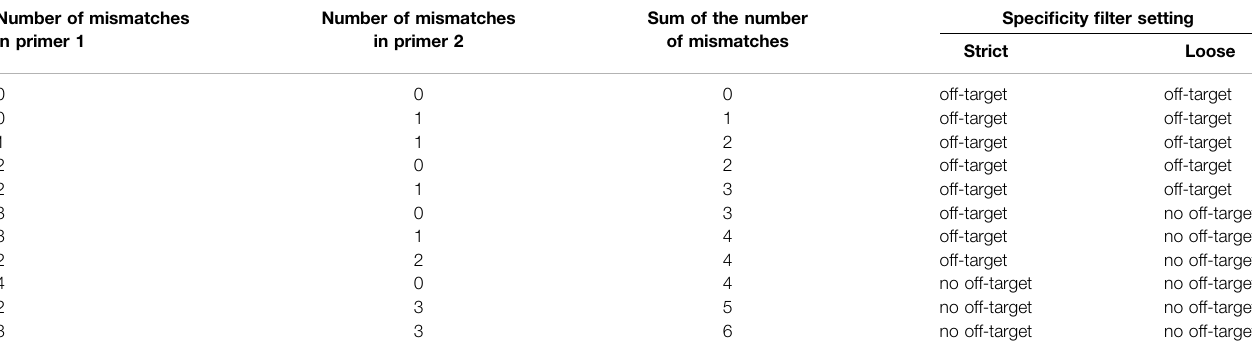
TABLE 1 | Tolerated off-targets for circRNA primers (based on (Lefever et al., 2013)). When the speci fi city fi lter of CIRCprimerXL is set to “ strict ” (default), primers with predictedoff-targetsarediscarded,unlessthereareatleast4mismatchesforasingleprimeroratotalofatleast5mismatchesbetweentheprimersandthepotentialoff- target sequence. Alternatively, the speci fi city setting can be set to “ loose ” , where at least 3 mismatches for a single primer or a total of at least 4 mismatches between the primers and the potential off-targets are also allowed. Number of mismatches in primer 1